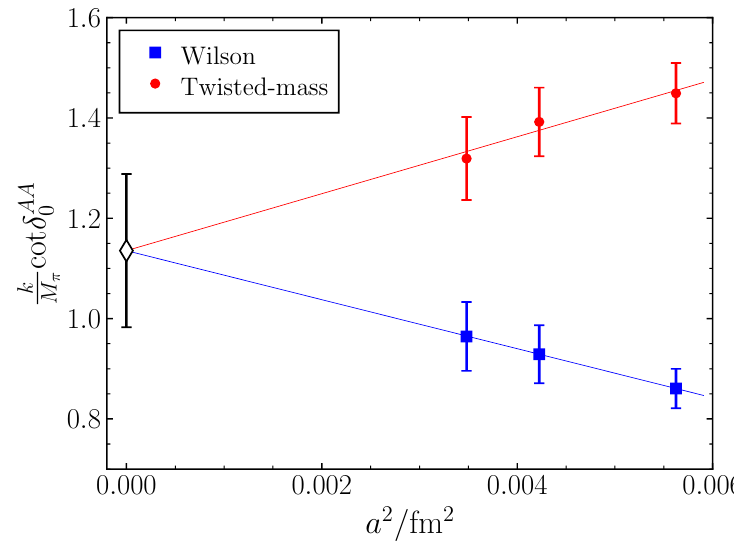
Figure 10 . Continuum extrapolation of ( k/M π ) cot δ 0 . Data from the pure Wilson (blue) and mixed-action (red) setups is fitted simultaneously with a constrained common continuum limit, depicted by an empty